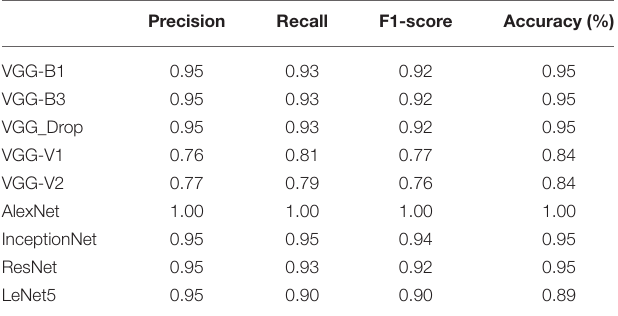
TABLE 7 | Comparative results obtained (Precision, Recall, F1-score, and Accuracy) for all algorithms employed.